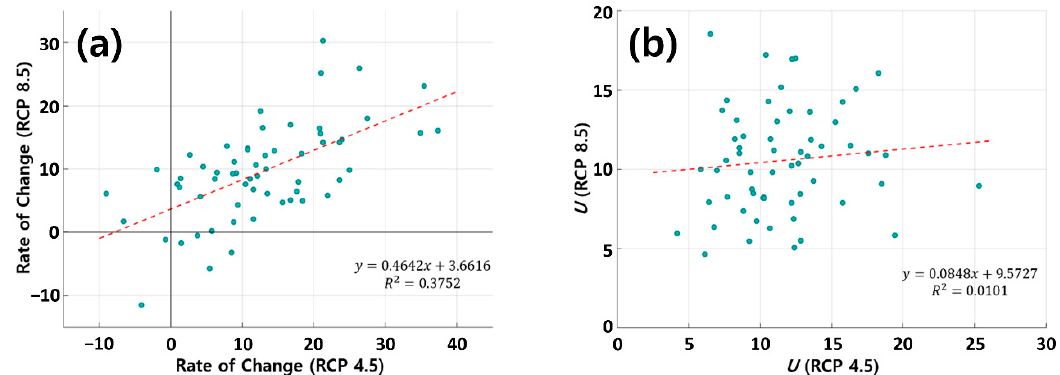
Figure 12. Comparison of correlations for which RCP was applied (duration 3 h and return period 30 years) in terms of ( a ) rate of change, and ( b ) its uncertainty 𝑈 .